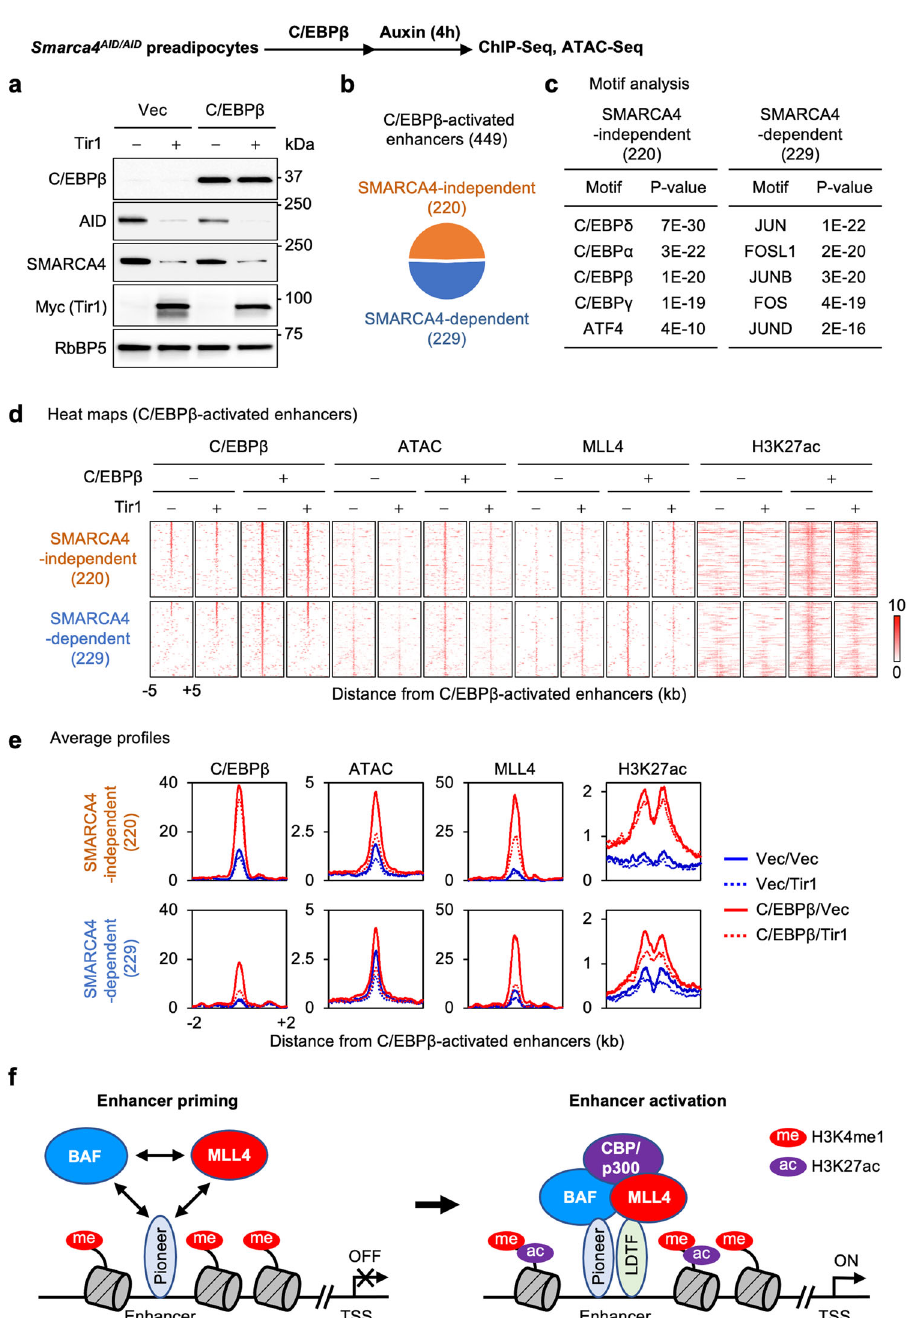
Fig. 8 BAF regulates MLL4 binding on C/EBP β -activated enhancers. Smarca4 AID/AID brown preadipocytes were infected with retroviruses expressing C/ EBP β or vector (Vec), and then infected with retroviruses expressing Tir1. Sub-con fl uent cells were treated with auxin for 4 h and collected for Western blot, ChIP-Seq and ATAC-Seq analyses. a Western blot analyses using antibodies indicated on the left. n = 3 biological replicates. b Among the 449 C/ EBP β -activated enhancers in preadipocytes, 220 exhibited SMARCA4-independent C/EBP β binding, while the remaining 229 showed SMARCA4- dependent C/EBP β binding. c Motif analysis of SMARCA4-independent and -dependent C/EBP β -activated enhancers in preadipocytes using SeqPos motif tool. d, e Auxin-induced, Tir1-dependent acute depletion of SMARCA4 reduces MLL4 binding on C/EBP β -activated enhancers in preadipocytes. Heat maps ( d ) and average pro fi les ( e ) around C/EBP β -activated enhancers are shown. Enhancers shown in the heat maps were ranked by the intensity of C/EBP β at the center in control cells expressing ectopic C/EBP β . f A model depicting the interdependent relationship between BAF and MLL4 in promoting pioneer TF- and LDTF-dependent cell type-speci fi c enhancer